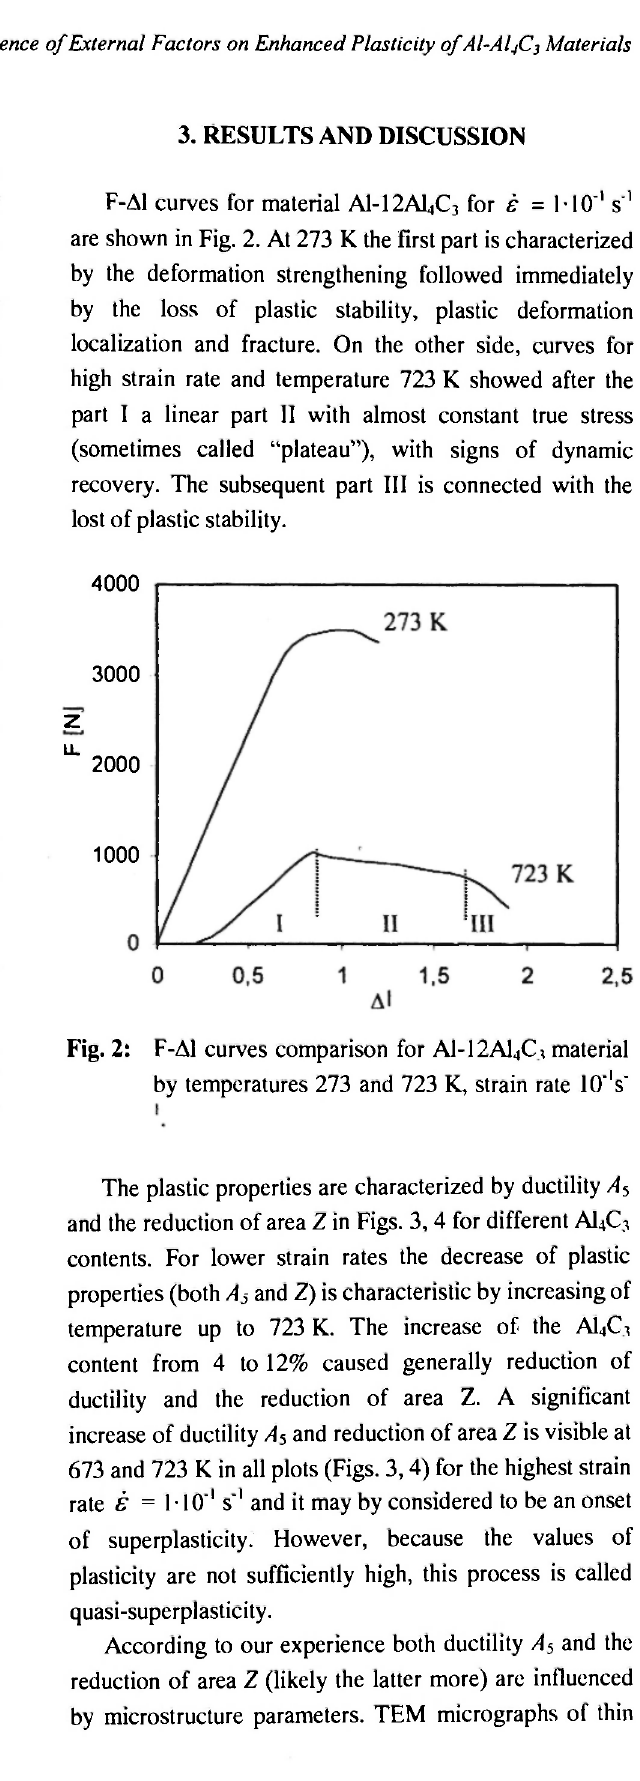
Fig. 1: The specimen for tensile tests.